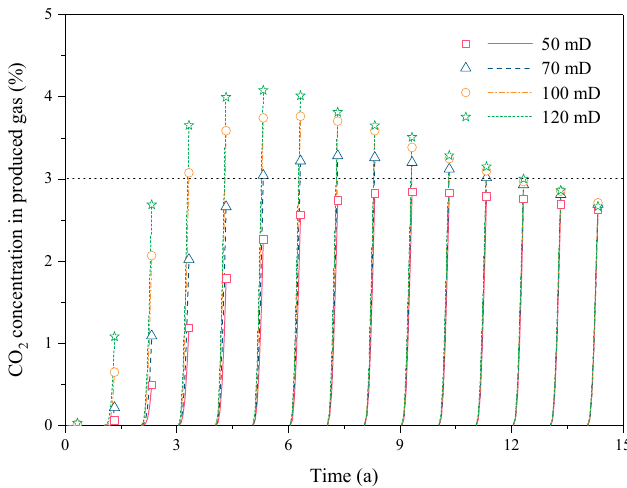
Figure 18. CO 2 concentration in the produced gas for di ff erent reservoir horizontal permeabilities.